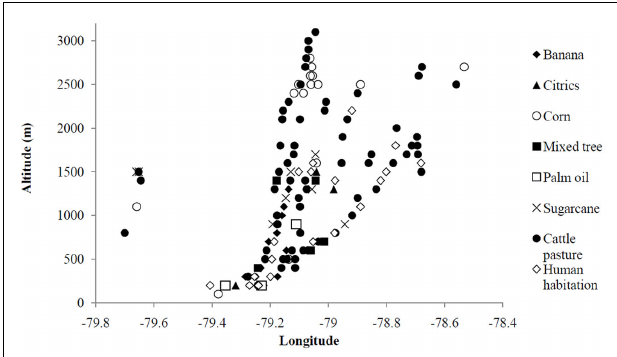
FIGURE 1 | Generalized land uses observed along six altitudinal transect in the western EcuadorianAndes, plotted by longitude. Elevations of biological interest are indicated within a black rectangle and land use types are indicated by symbols (see legend).